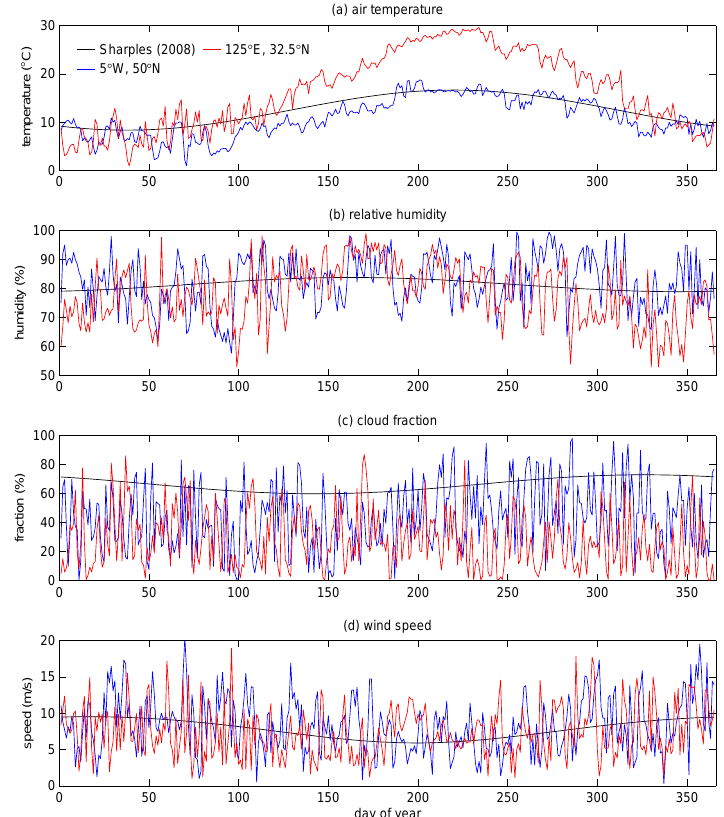
Figure 2. Daily meteorological data: climatological for the northwest European shelf (Sharples, 2008), and for 2013 in the western English Channel, and in the East China and Yellow seas: (a) air temperature; (b) wind speed; (c) cloud fraction; (d) relative humidity.